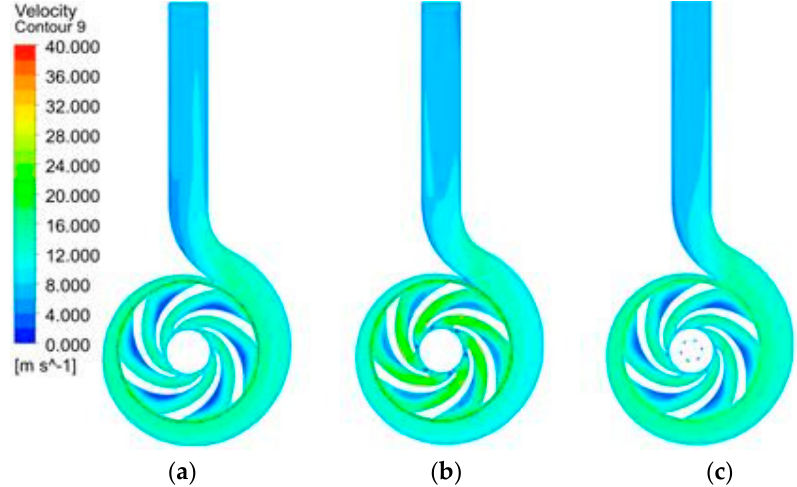
Figure 7. Comparison of the X – Y plane velocity contour of the pump without balancing holes and pumps and Type A and B balancing holes of 4 mm diameter: ( a ) without balancing holes; ( b ) with Type A balancing holes; ( c ) with Type B balancing holes.